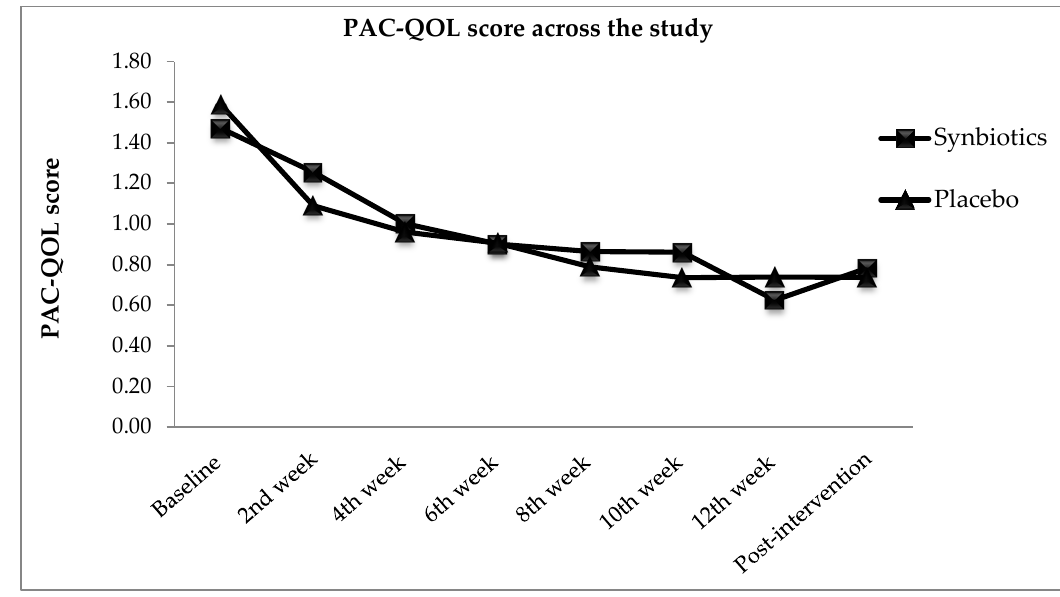
Figure 5. Patients Assessment on Constipation Quality of Life (PAC-QOL) scores from baseline, intervention, and post-intervention.